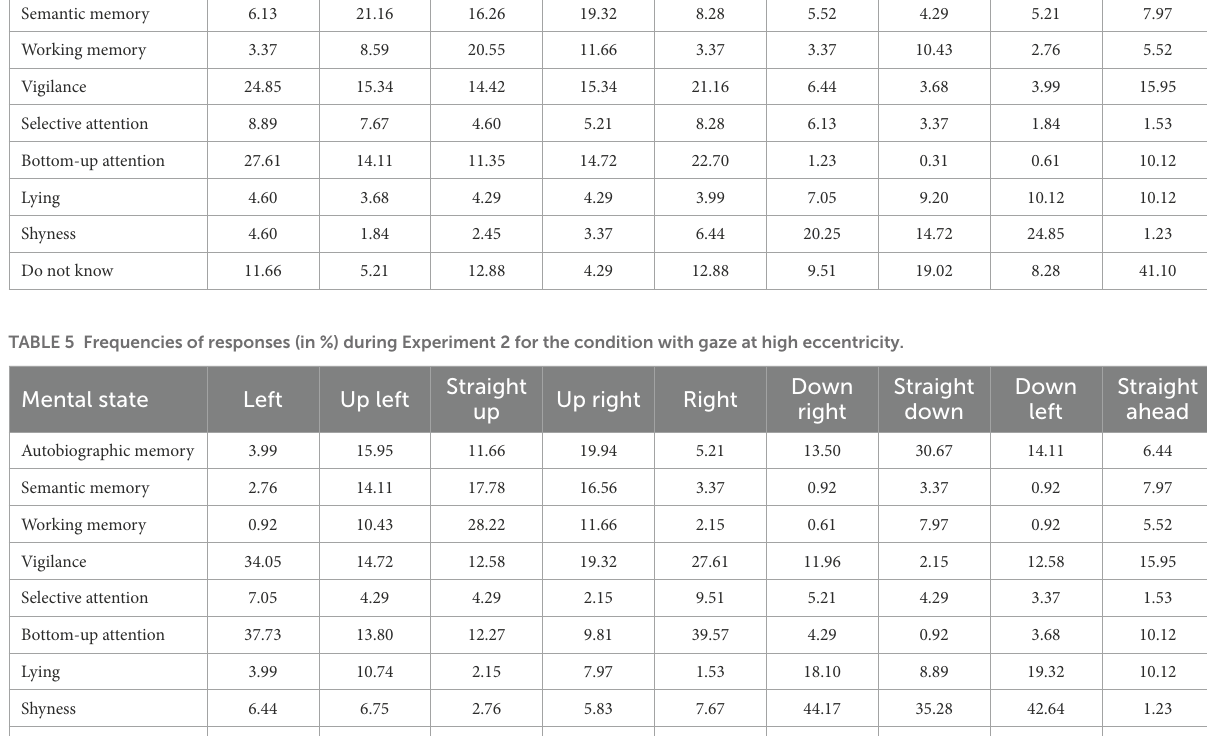
Straight Up right Right up